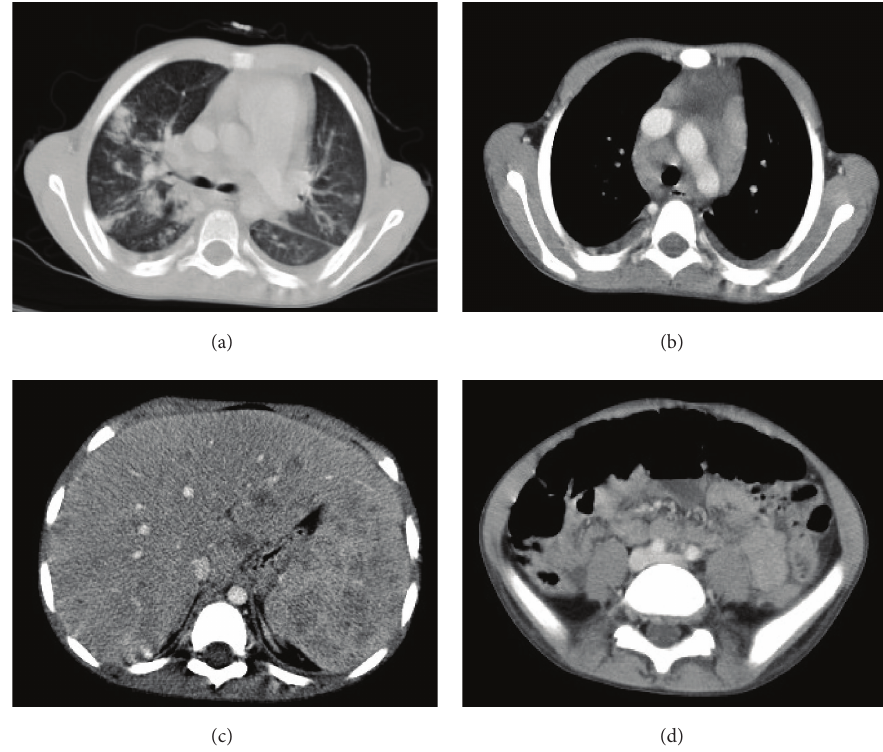
Figure 2: Thoracoabdominopelvic computed tomography in axial sections demonstrating scattered nodules at different parenchymal lung segments, a right parenchymal lung condensation, and minimal pleural effusion (a), multiple mediastinal enlarged lymph nodes (b), hepatosplenomegaly containing multiple nodular hypodense lesions (c), and hilar and para-aortic infracentimetric lymph nodes